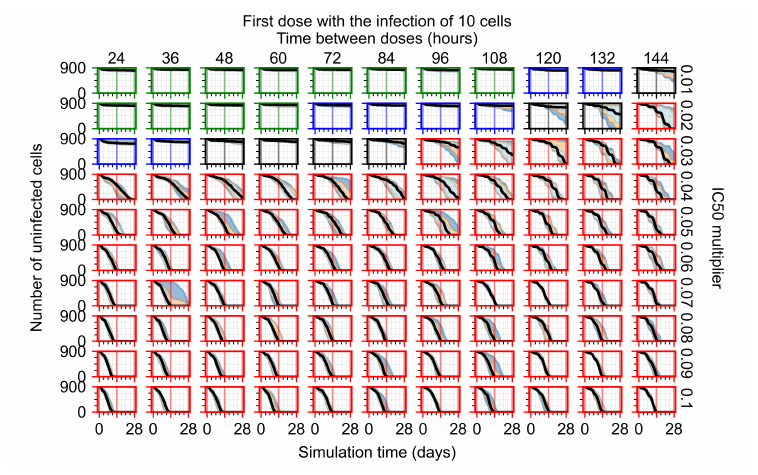
Figure A39. Uninfected population.